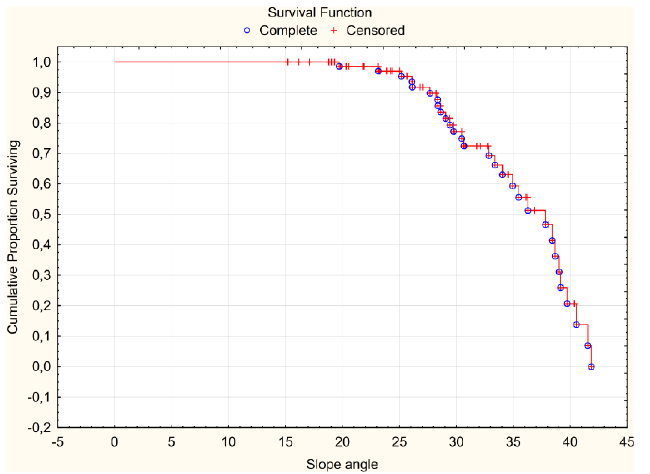
Fig 6. Survival Function for Slope